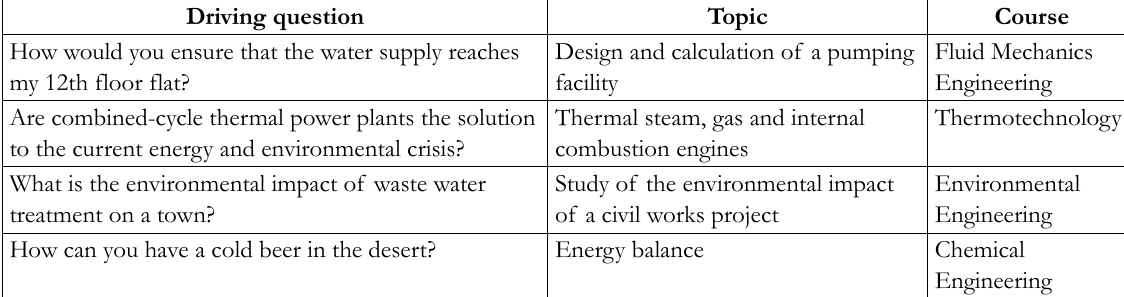
Table 1. Examples of Problem- and Project-Based Learning